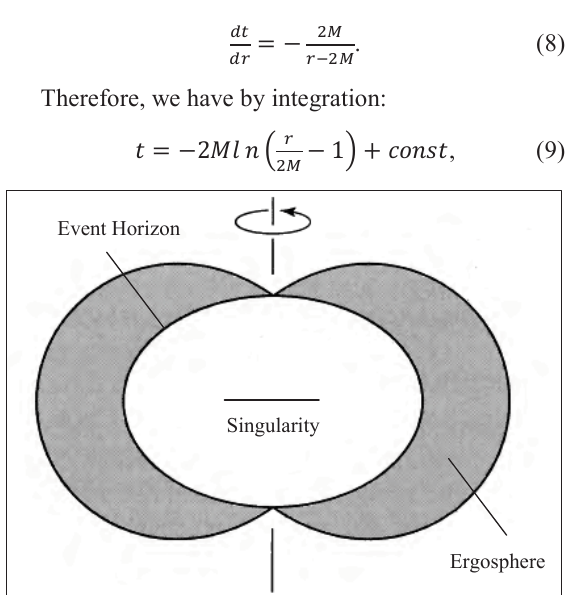
Fig. 2. The structure of rotating black